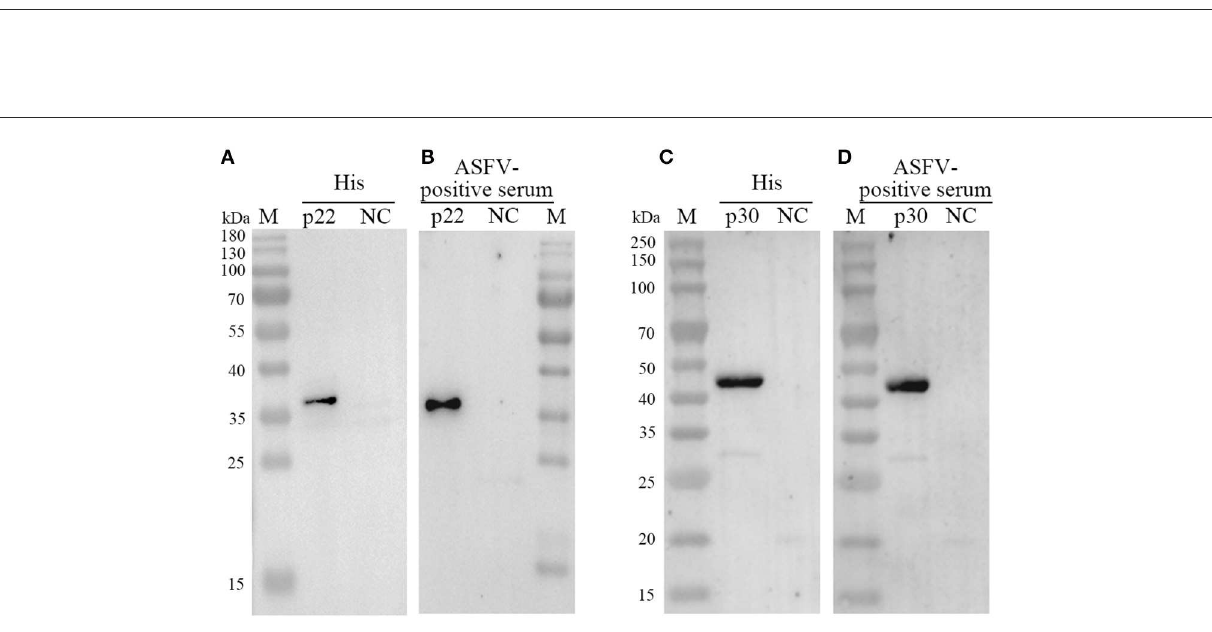
FIGURE3 Determination the expression of p22 and p30. (A, C) The expression of p22 protein (A) and p30 protein (C) was determined by anti-His antibody. (B, D) The expression of p22 protein (B) and p30 protein (D) was immunoreactive with ASFV-positive serum.